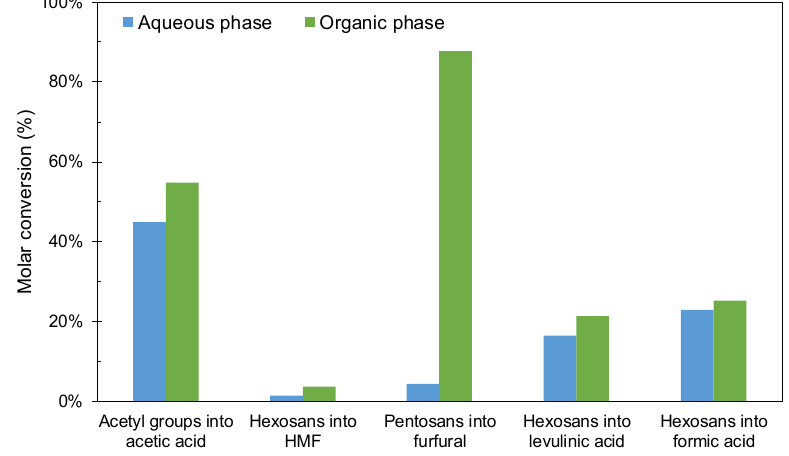
Figure 8. Conversions achieved at 190 °C using [C4SO 3 Hmim]HSO 4 as a catalyst.